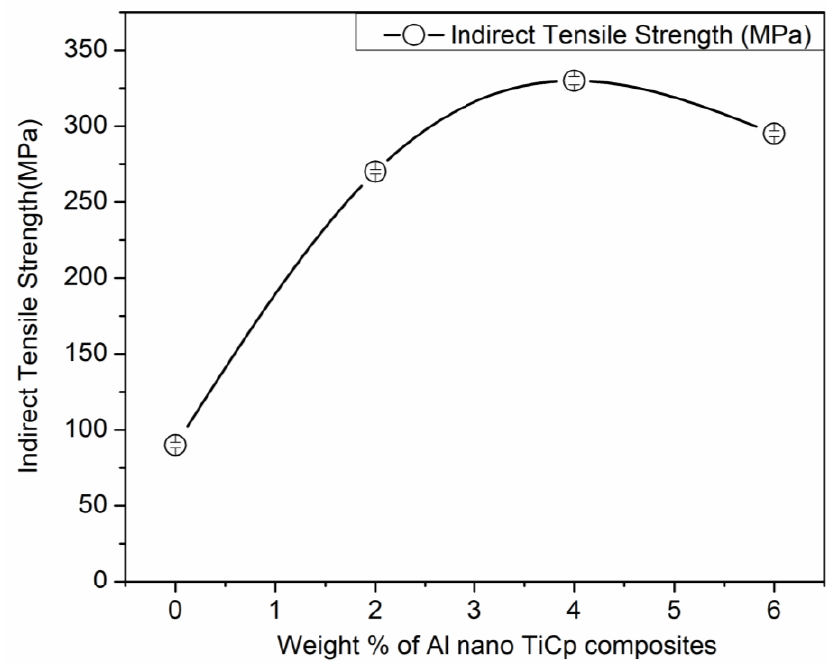
Figure 7. Indirect tensile strength of sintered Al nanoTiC p composites.